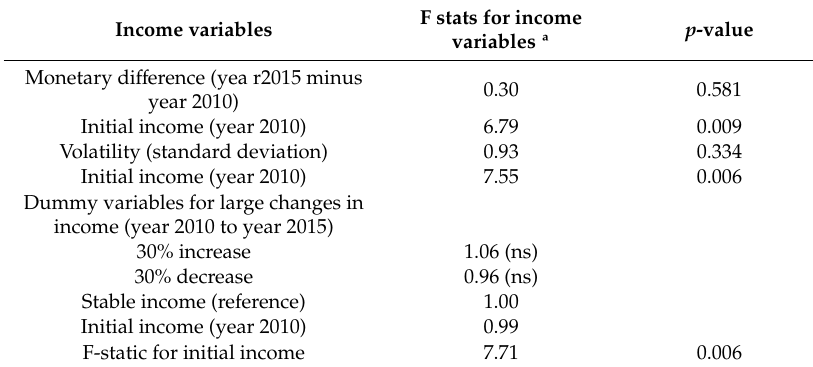
Figure A1. Prevalence of multimorbidity by age and income. Table A3. Income change and